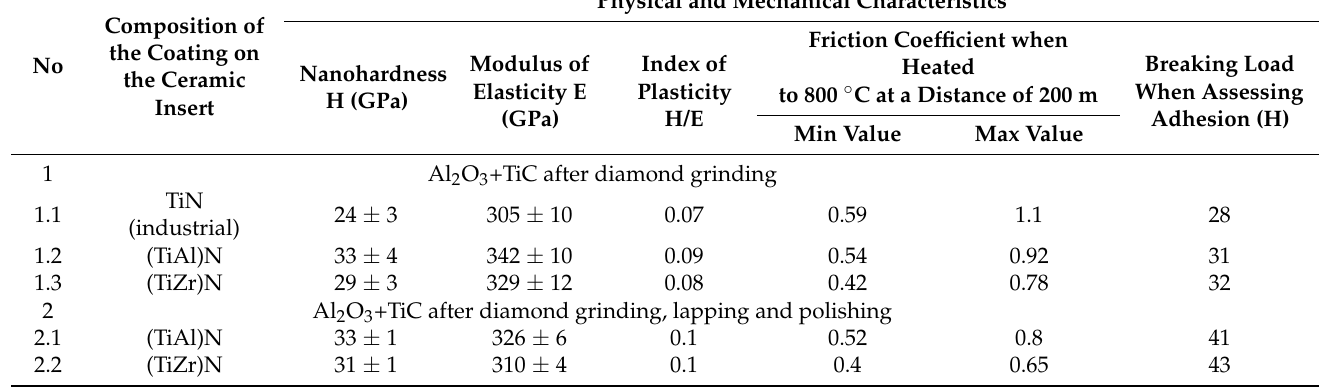
Table 4. Physical and mechanical characteristics of coatings deposited on Al 2 O 3 +TiC ceramic inserts with different conditions of the surface